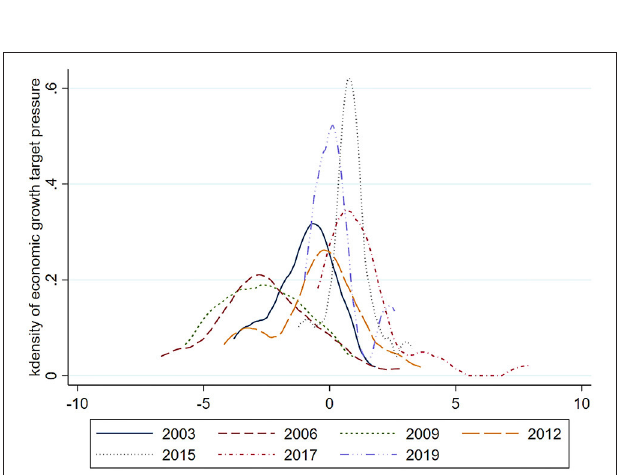
FIGURE 3 | Kdensity of the pressure to reach economic growth targets.